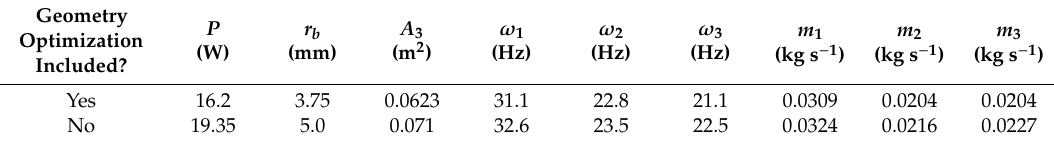
Table 4. Comparison of synergetic optimization results of the